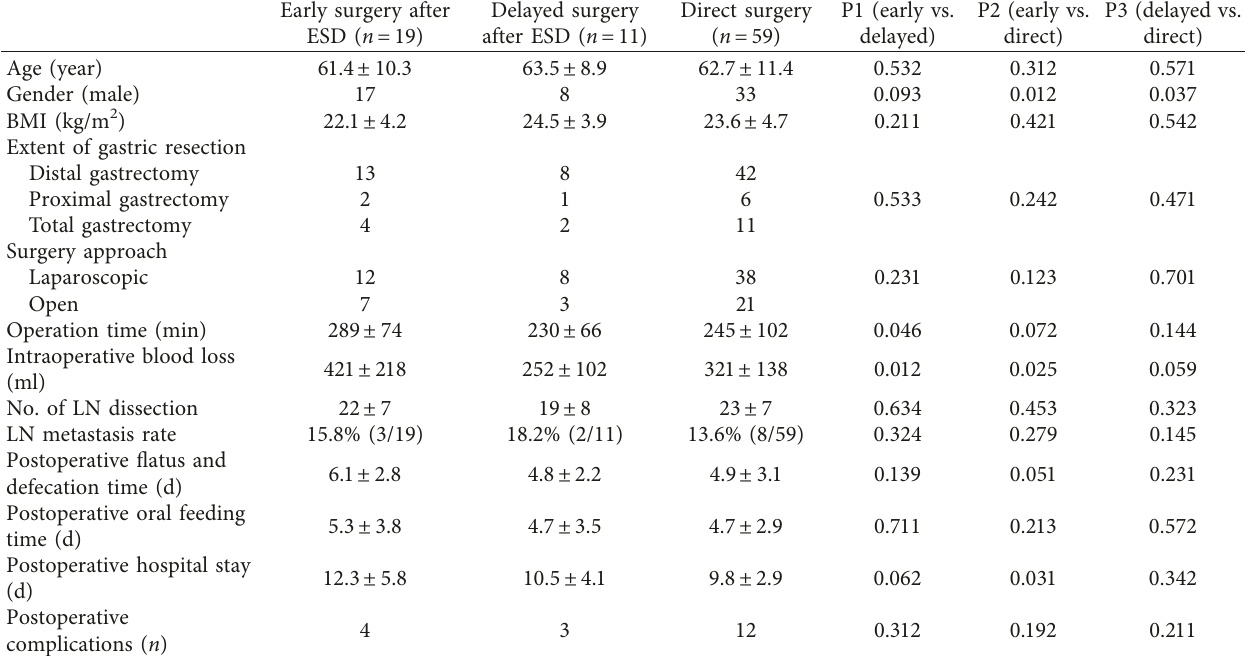
Table 5: Comparison of safety and radical resection between different surgery timing for early gastric cancer. Early surgery